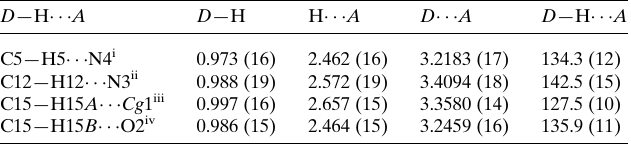
Table 2 Experimental details. Crystal data Chemical